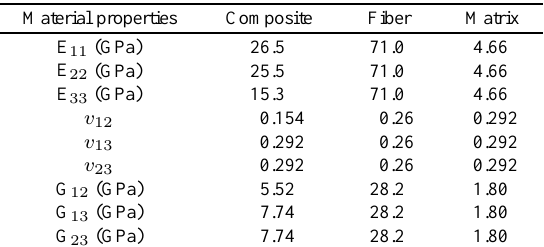
Table 1 Material properties ofcomposite and its constituents at its virgin